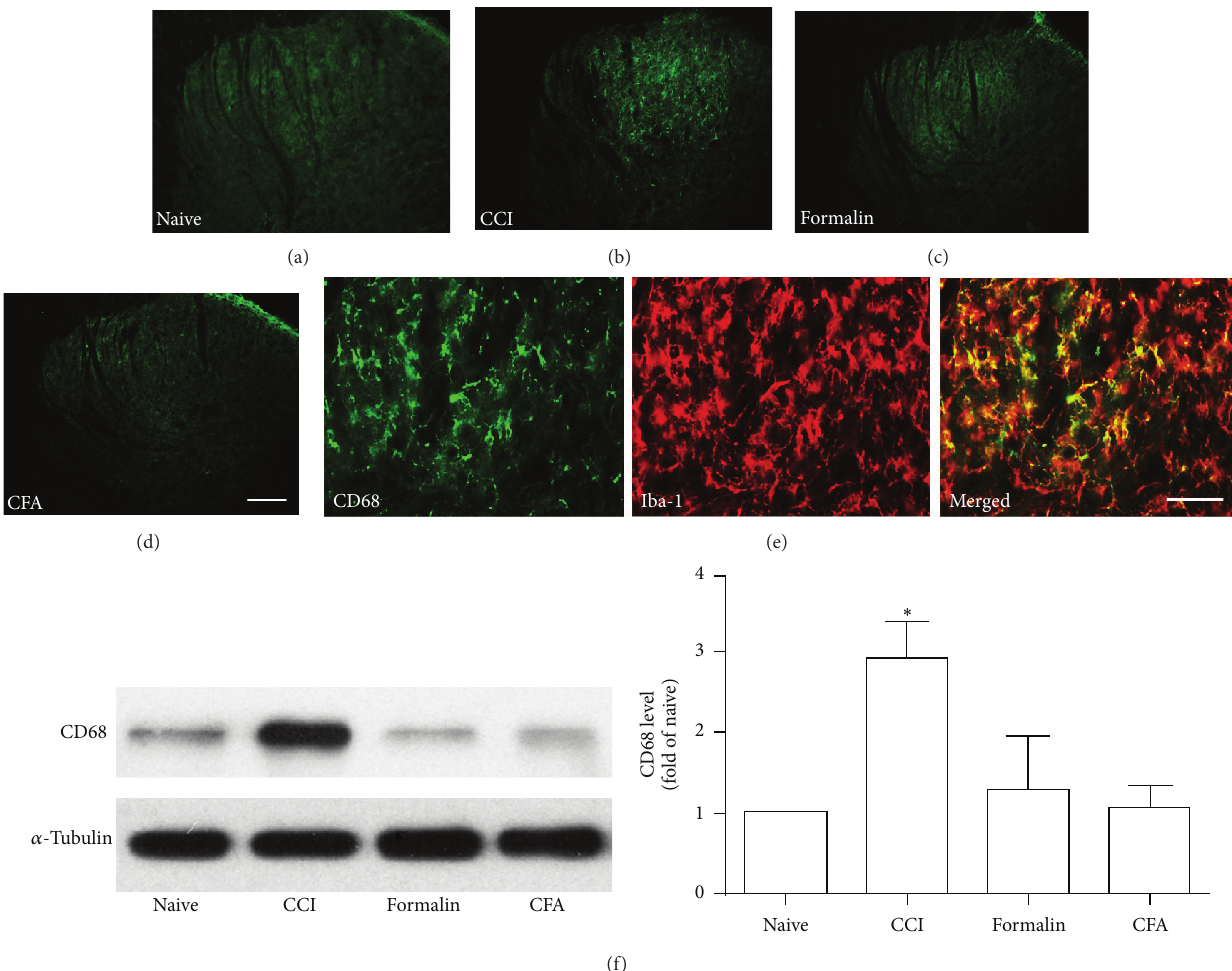
Figure 4: A significant increase of CD68 expression was present only following CCI injury, which was weak after formalin and CFA injection ((a)–(d); Scale bar, 100 𝜇 m). CD68 positive cells were colocalized with Iba-1 ((e); Scale bar, 50 𝜇 m). Representative bands of Western blot and quantification of Western blot analysis (f) showed increased level of CD68 in CCI group. ∗ 𝑃 < 0.05 as compared with the na¨ıve group, 𝑛 = 4